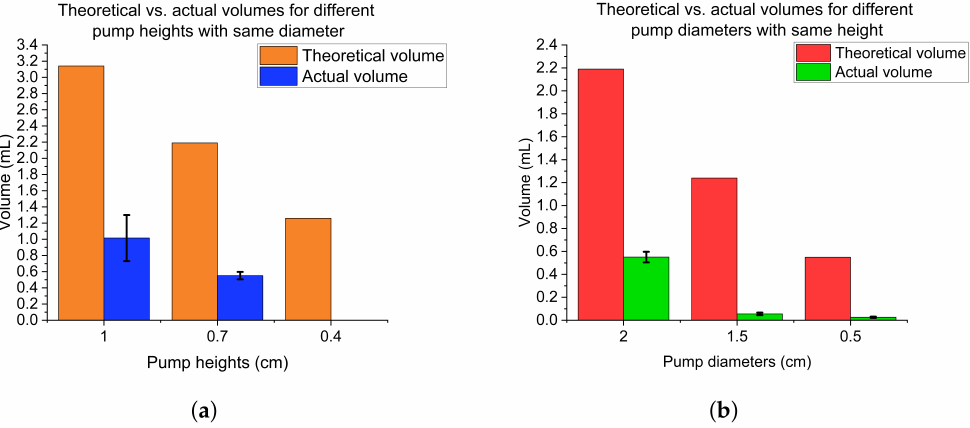
Figure 3. ( a ) Theoretical and actual volumes for three PDMS micropumps with different heights; ( b ) Theoretical and actual volumes for three PDMS micropumps with different diameters.